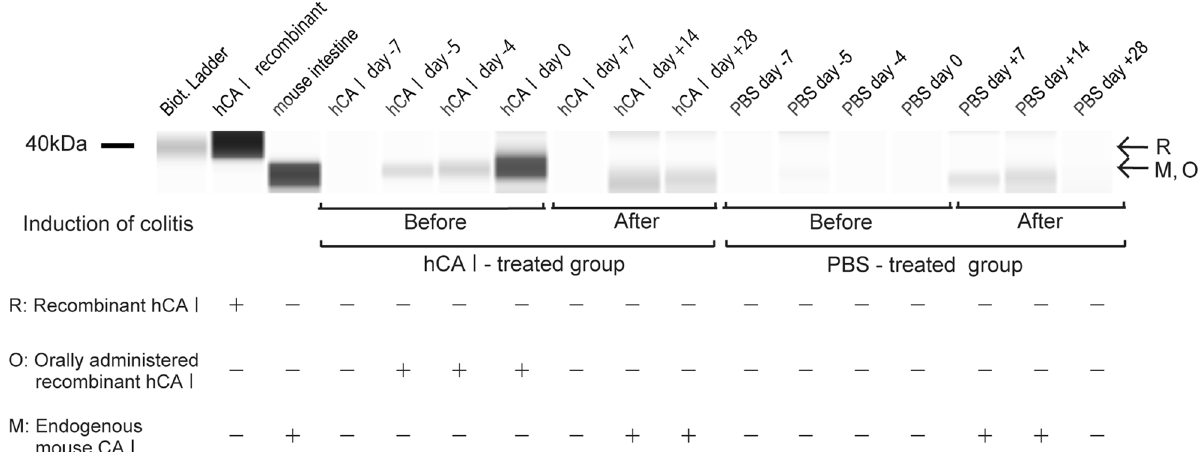
Figure 3. Quantification of hCA I or mouse CA I in feces. Changes in CA I protein (including mouse CA I and recombinant hCA I) content in feces before and after oral administration (PBS: control group) detected using immunoblot. R recombinant hCA I; O orally administered hCA I; M mouse CA